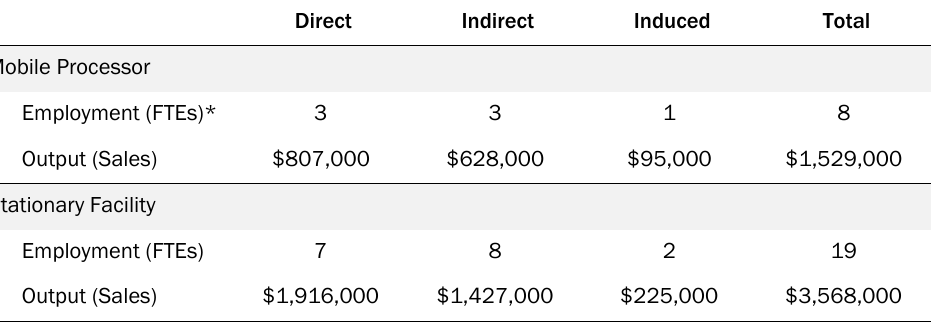
Table 3. Economic Impacts of Proposed Livestock Processing Facilities (Sales in